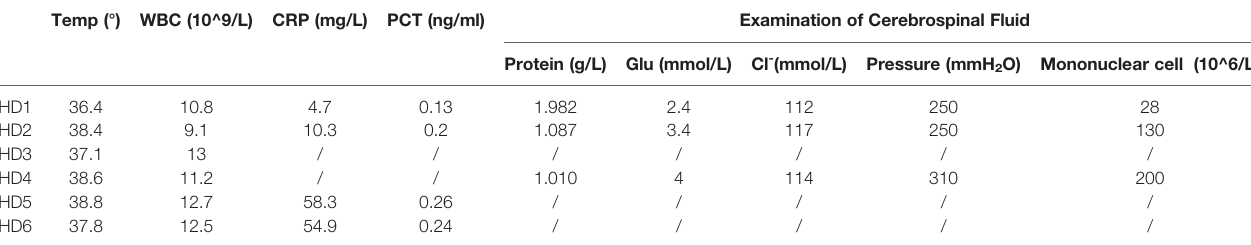
HD, hospitalization day; Temp, Temperature; WBC, white blood cell; CRP, C-reactive protein; PCT,